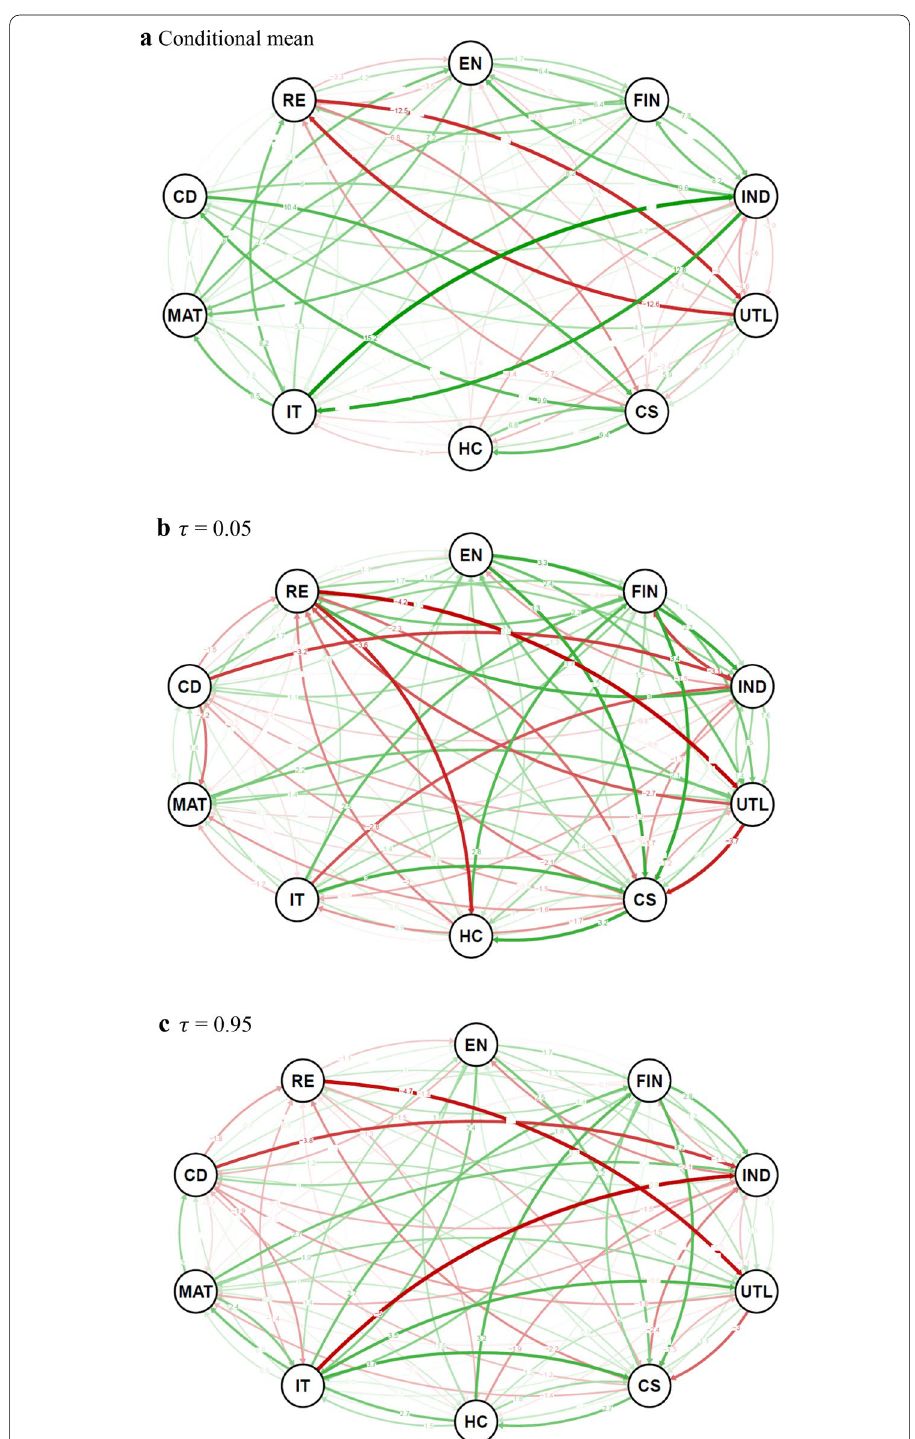
Fig. 8 Change in spillover for pre and post COVID19 sub-sample. a Conditional mean, b τ Note: These graphs of US sector networks show the difference in connectedness in a system that consists of the US sectors for the pre- and during COVID19 sub-sample periods (each sub-sample contains 204 days). The connectedness is measured through the spillover approach proposed by Diebold-Yilmaz (2012). The thickness of an edge is proportional to its weight while colour implies increase (green) and decrease (red) in spillover during the COVID-19